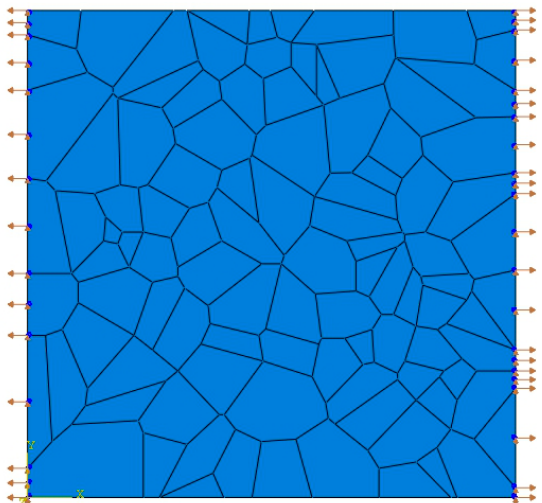
Figure 10. Load distribution. Figure 10. Load